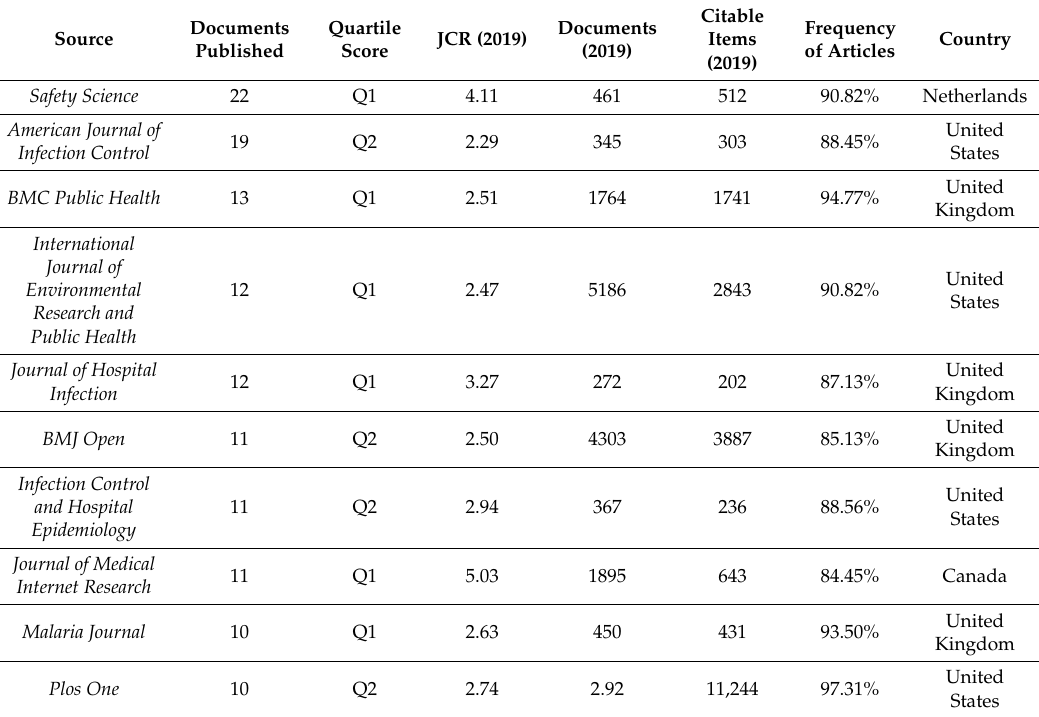
Table 5. Quartile and Journal Citation Report (JCR) of ten principal